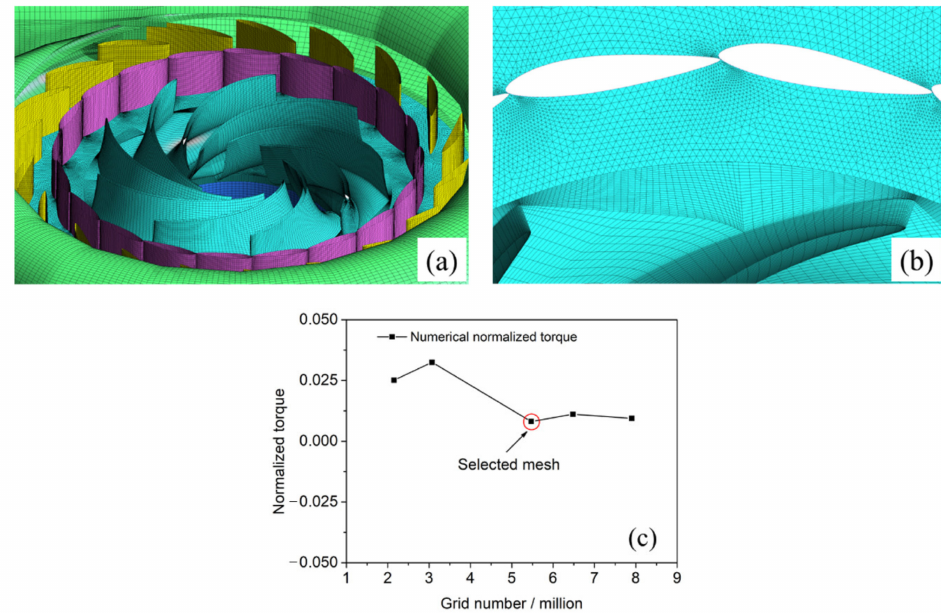
Figure 4. Schematic of mesh. ( a ) Grids for different parts; ( b ) Grids for guide vane region in the initial opening; ( c ) Mesh